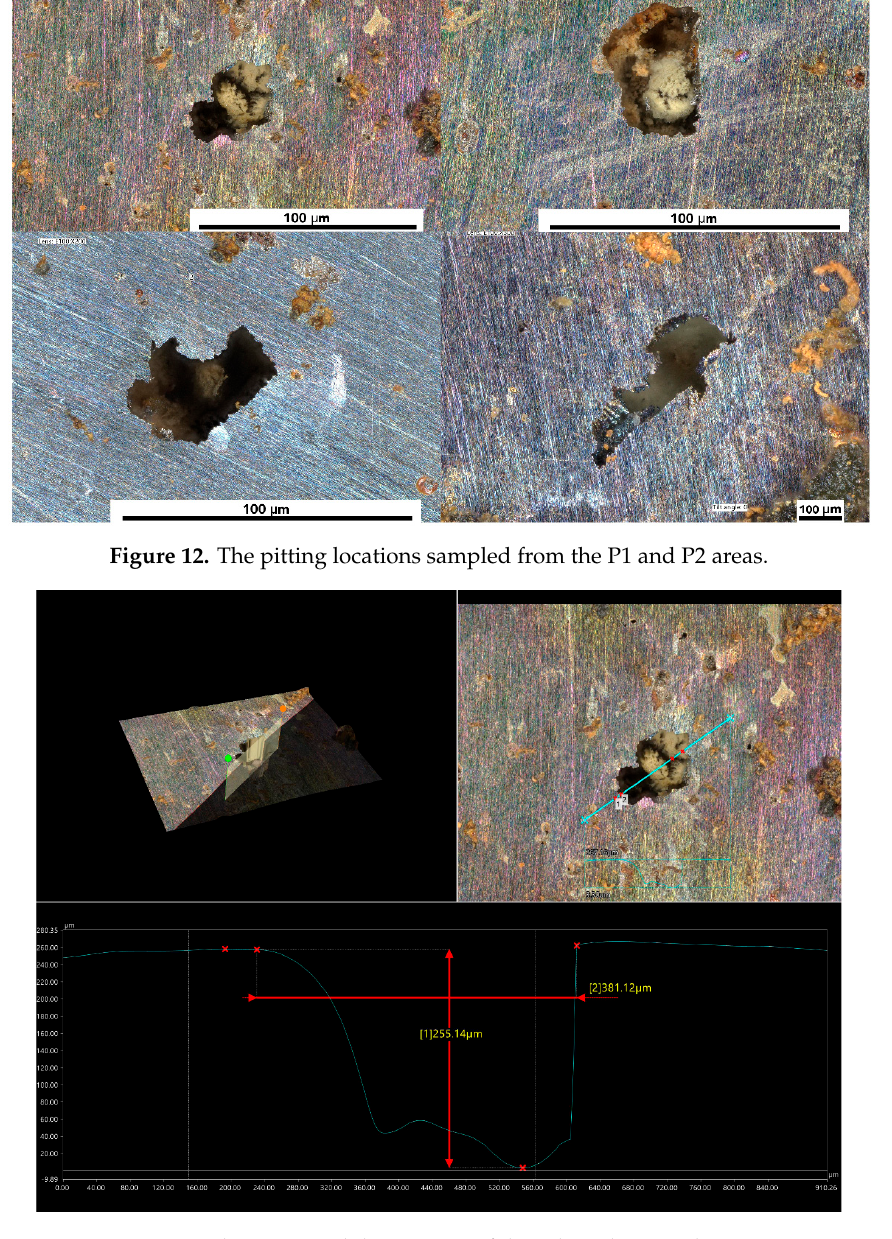
Figure 14. The intergranular corrosion testing results: ( a ) Cladding layer over weldment (G1); ( b ) Cladding-substrate layer over weldment (G2).